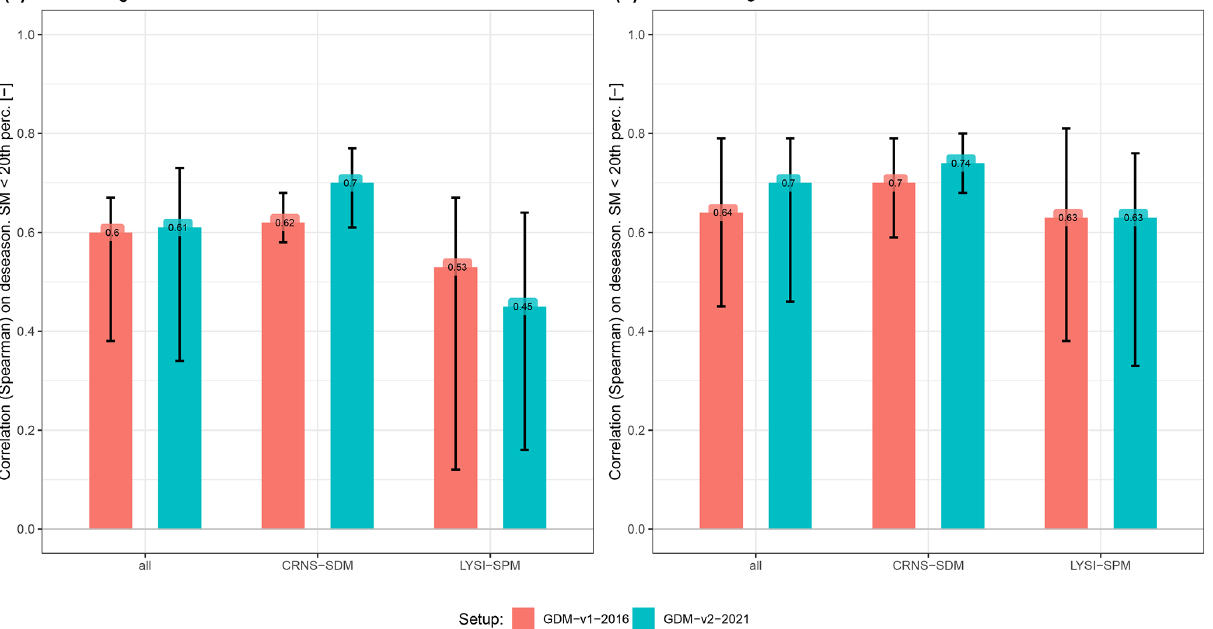
Figure 7. Correlations of deseasonalized daily SM below the 20th percentile (based on the observed SM time series) between simulations and observations (a) . In (b) , an additional statistical smoothing was applied by calculating a running 30d mean on the daily SM time series before subtraction of the seasonal cycle. The correlations are shown for all observations ( n = 46) and separated between observations with a larger spatial footprint ( n = 20), including cosmic-ray neutron sensing (CRNS) and spatially distributed measurements (SDM) as well as point measurements ( n = 26), including single profile measurements (SPM) and lysimeters (LYSI).